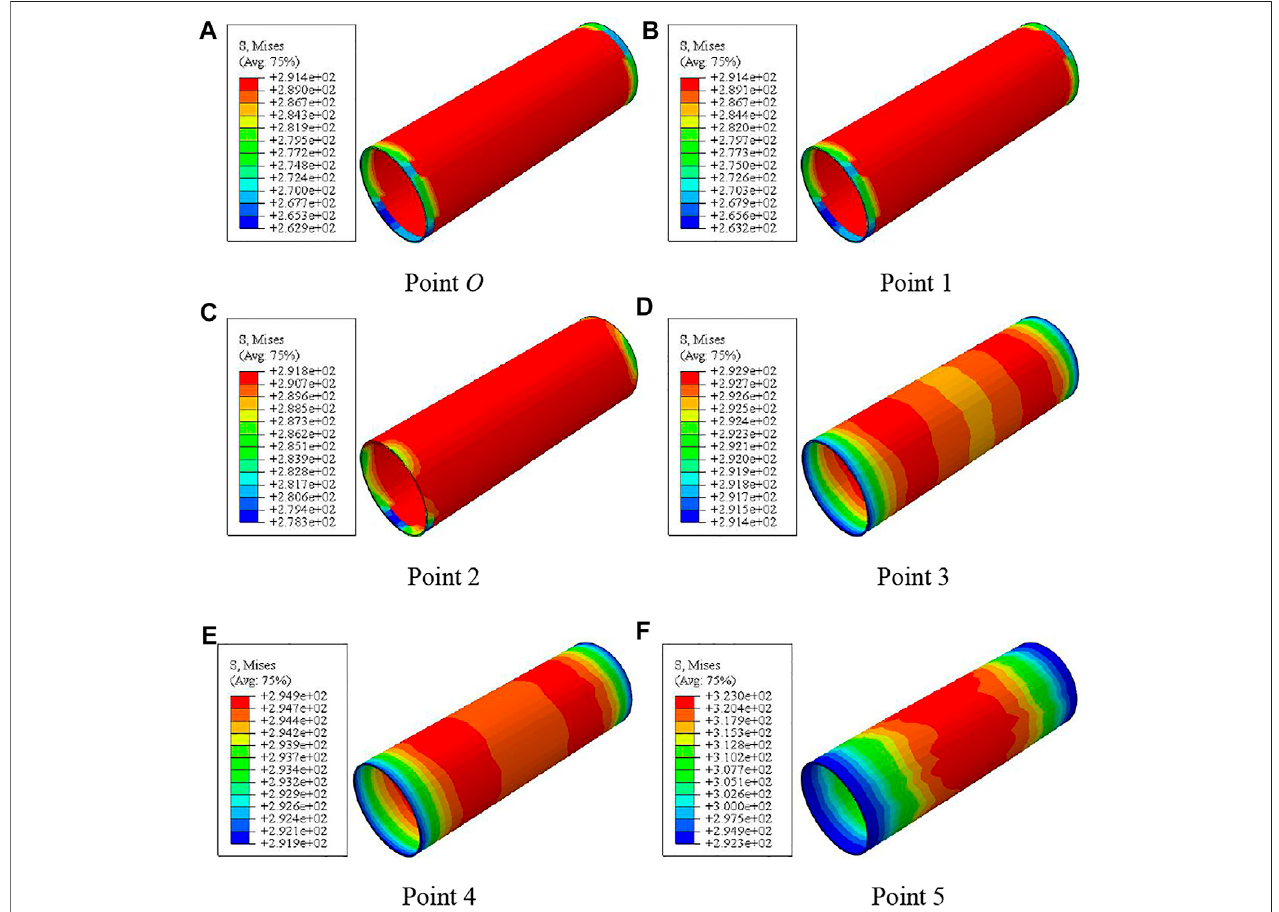
FIGURE 21 | Mises distribution of the steel tube. (A – F) Mises distribution of the steel tube at different 0 – 5 points.